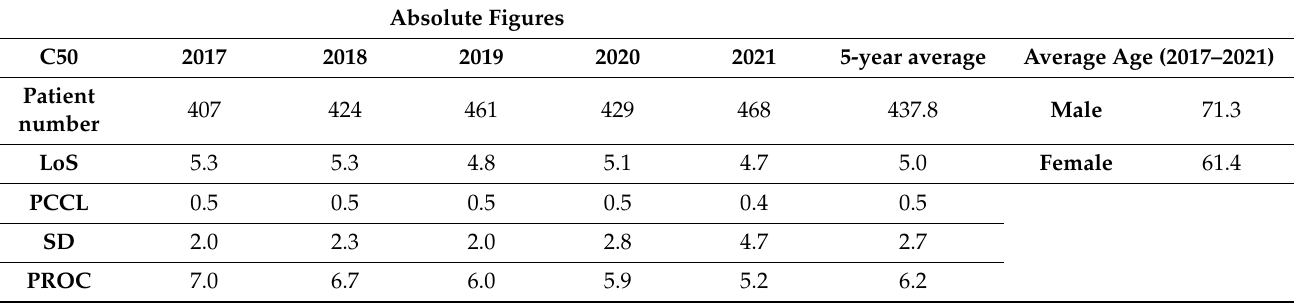
Table 1. Results of the C50 and C56 patient data